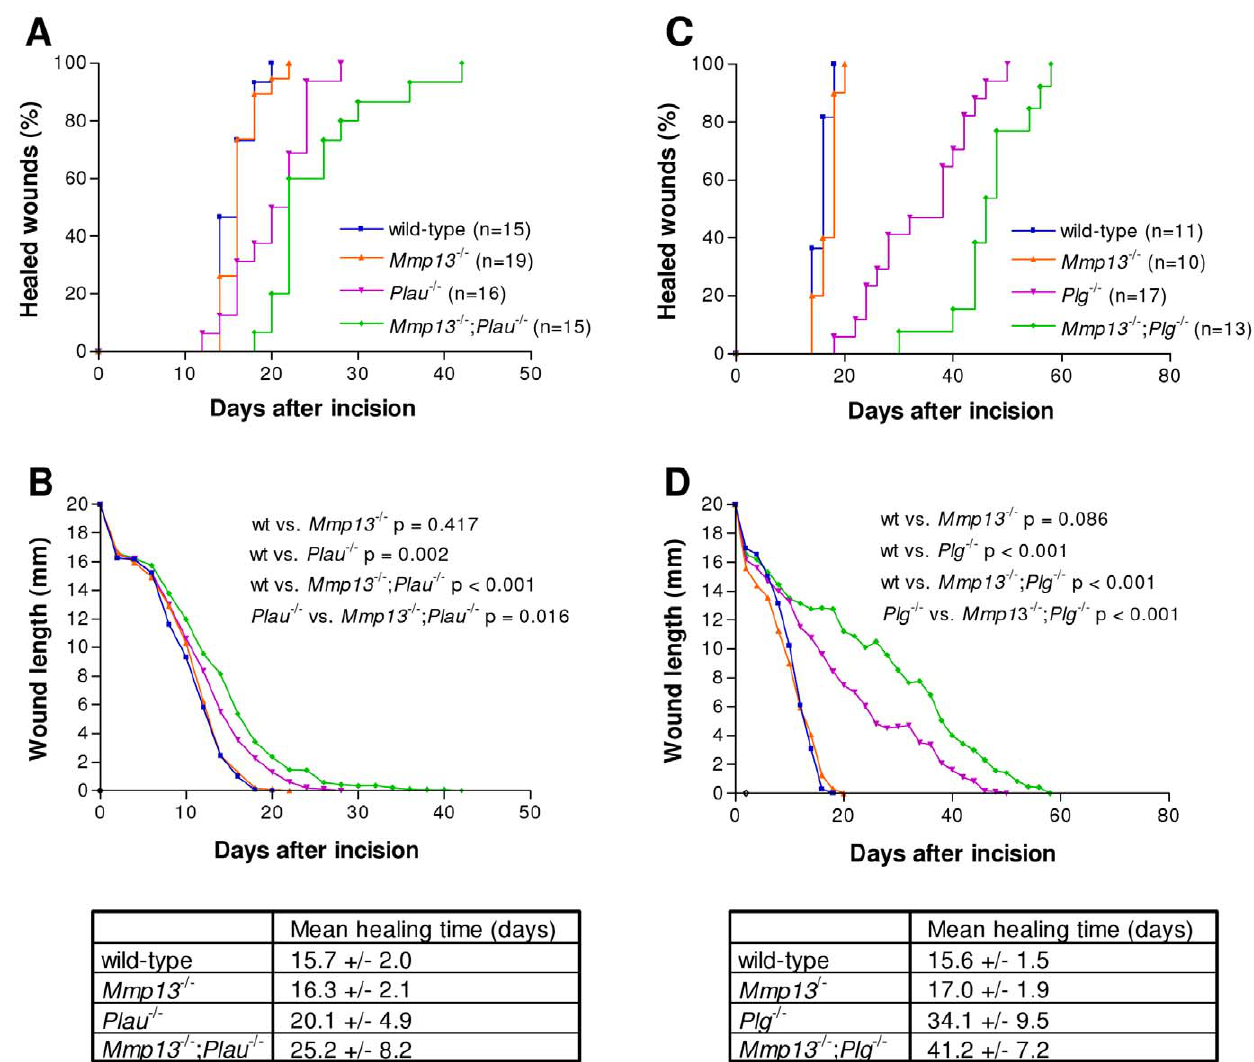
Figure 2. Time course of skin wound healing in Mmp13;Plau and Mmp13;Plg double-deficient mice. ( A + C ) The percentage fraction of mice with complete re-epithelialization is plotted vs. time after incision of 20 mm long wounds. ( B + D ) The average wound length is plotted vs. time after incision. Wound healing in Mmp13 -deficient mice is indistinguishable from that in wild-type mice, while wound healing in both Plau - and Plg - deficient mice is significantly delayed compared to wildtype wound healing (p=0.002 and p , 0.001 in a two-tailed t -test). However, Mmp13;Plau and Mmp13;Plg double-deficient mice have an additional significant delay in wound healing compared to either Plau - or Plg -deficient mice (p=0.016 and p , 0.001 in a two-tailed t-test), indicating a phenotypic overlap between MMP-13 and the PA